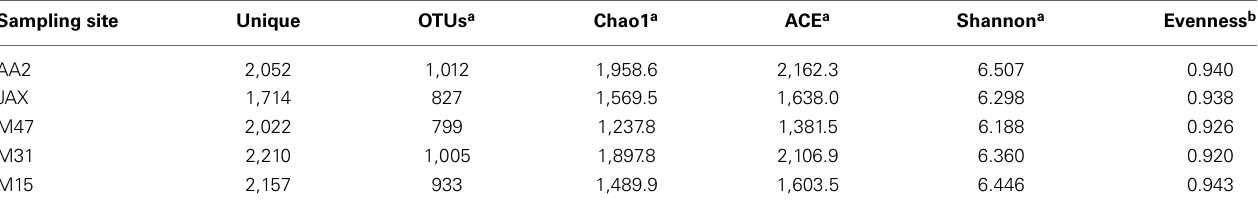
Table 4 | Estimates of sedimentary NrfA sequence richness and diversity in the New River